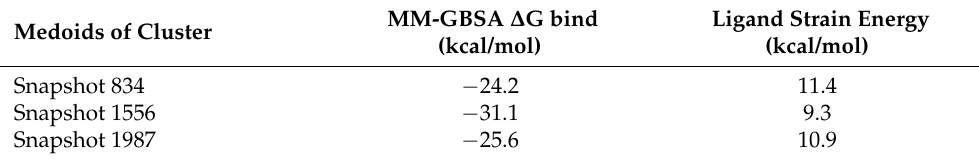
Table 2. ΔGbind energy and ligand strain energy values for each medoid of three clusters. Medoids of Cluster